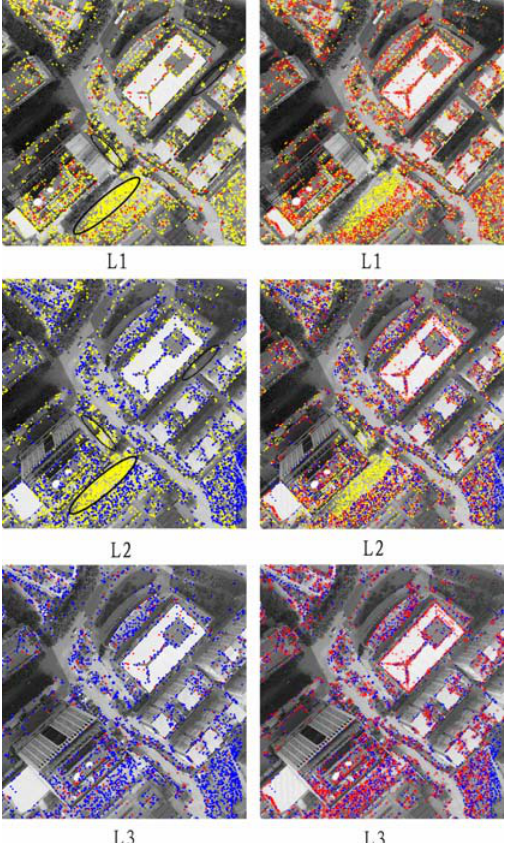
Figure 6. (left) The matching results of the second-best grid Figure 7. (right)The final results After the matching of the best grid cells and the